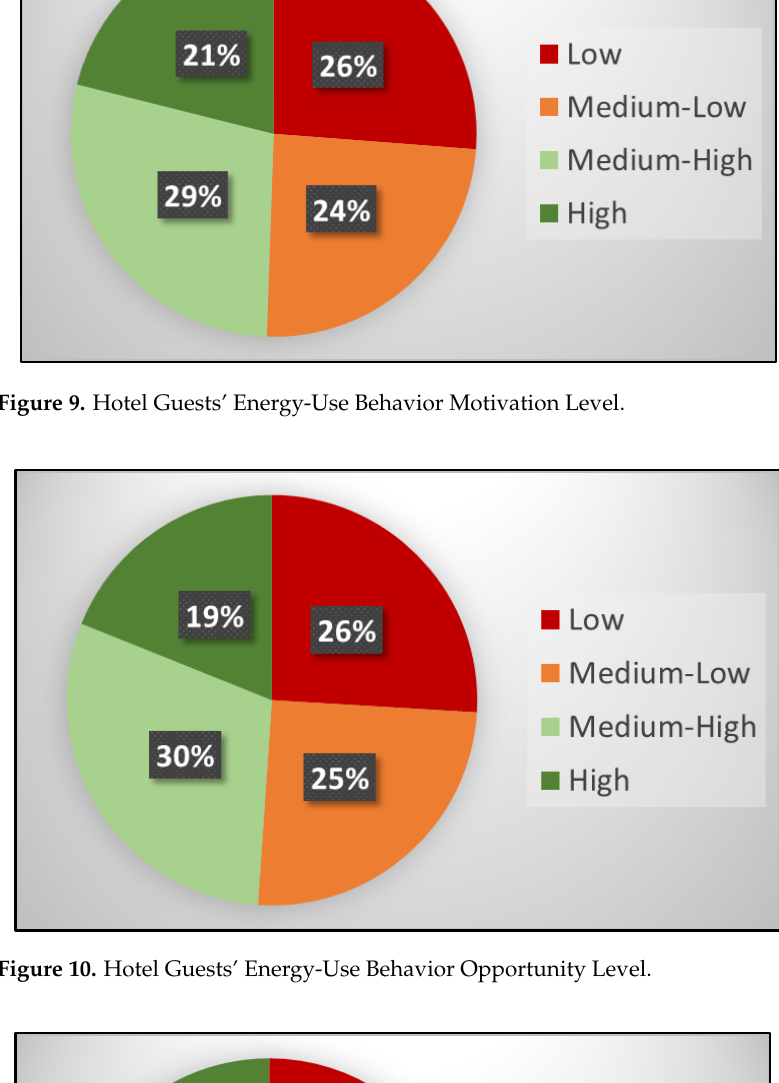
Figure 10. Hotel Guests’ Energy-Use Behavior Opportunity Level.